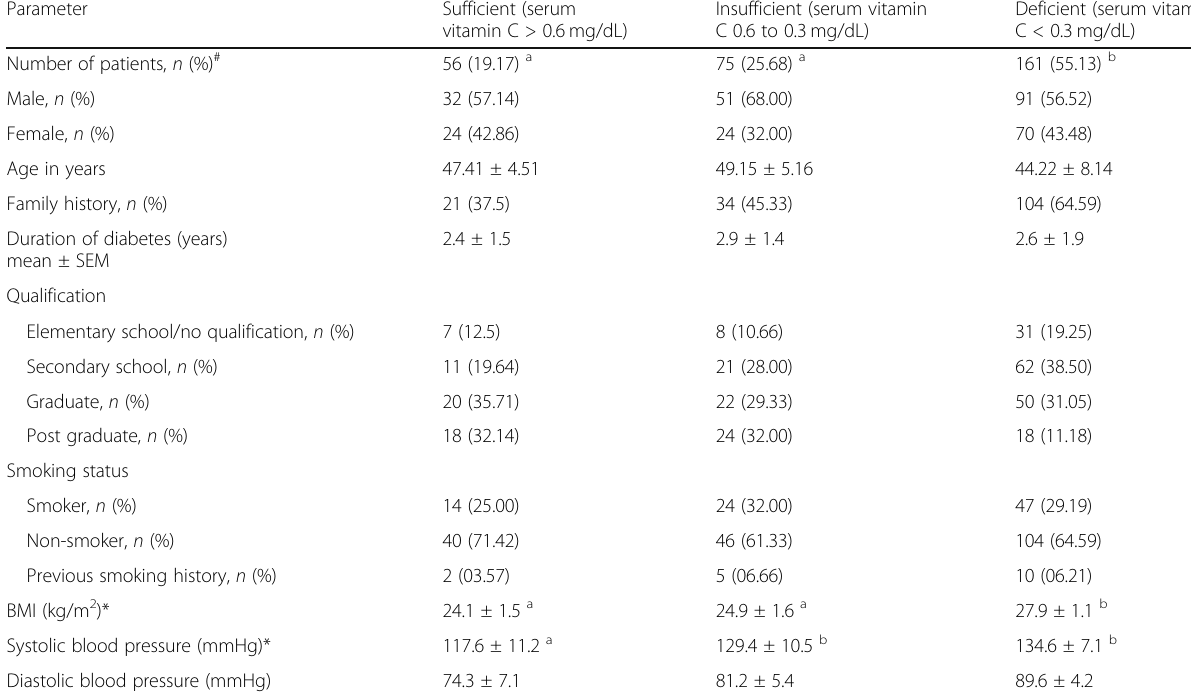
Table 1 Baseline characteristics of selected participants ( n = 292)